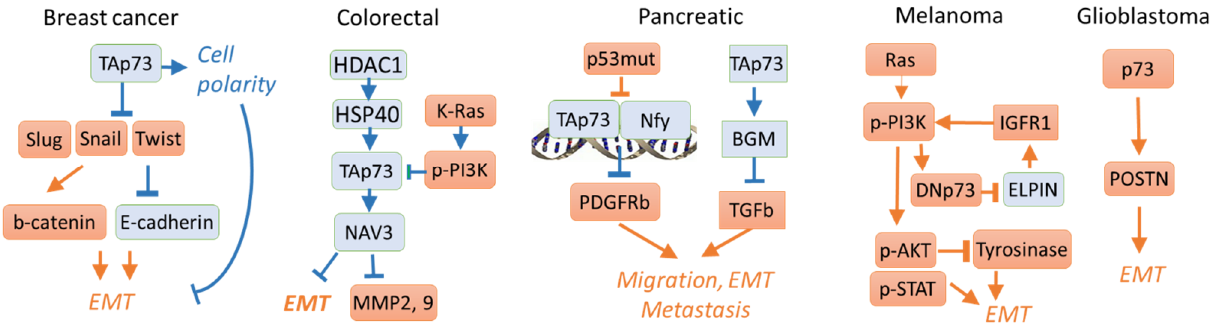
Figure 3. The p73-regulated signalling pathways influence EMT, mobility, or invasiveness in cancer models. In blue shown is the EMT repressive and in red—the EMT-promoting signalling. TAp73 inhibits EMT, mobility, and invasion for breast [116], colorectal [89,120,126] or pancreatic cancers [121,122]. However, the induction of DNp73 inhibits EMT and metastasis in melanoma [127,128]. In glioblastoma, total p73 depletion induces an invasive phenotype in the POSTN-dependent manner [135].